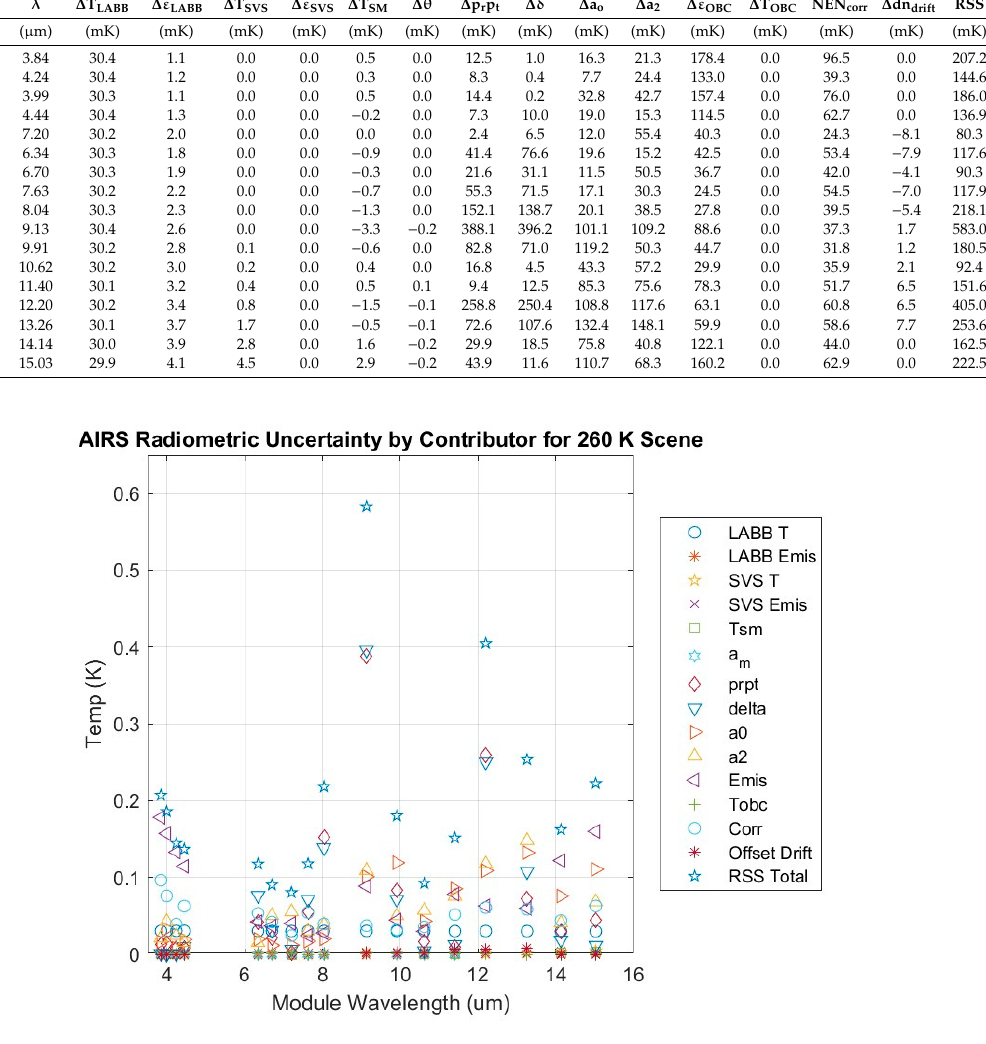
Figure 9. Module median radiometric uncertainties for V5 for each of the contributors expressed at 260 K scene temperature. Uncertainties represent the 1-sigma deviation from the SI-traceable sensors in the